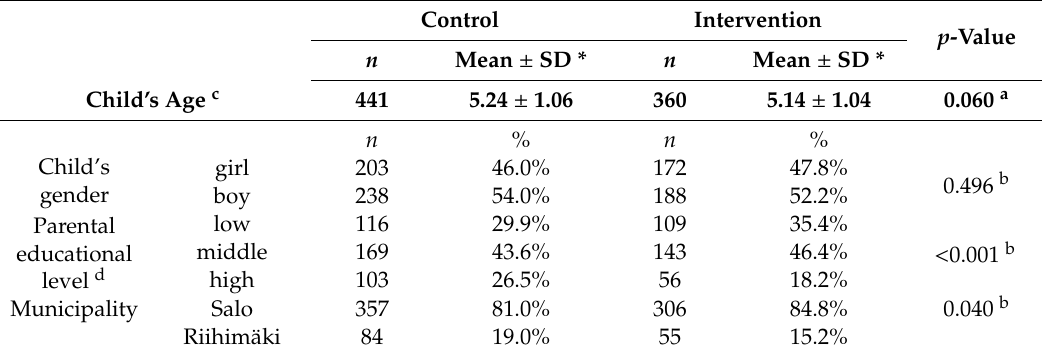
Table 1. Children’s characteristics by the control and intervention group at baseline ( n = 802).